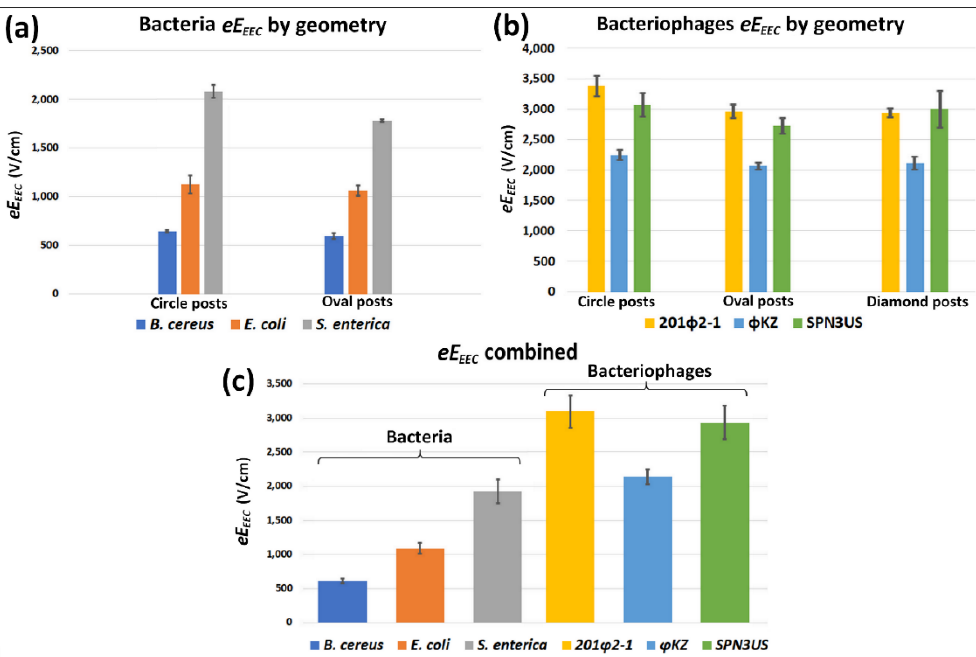
Figure 3. The 𝑒𝐸 𝐸𝐸𝐶 values are presented in each post shape per species for ( a ) the bacteria [13] and for ( b ) the bacteriophages [9]. ( c ) The 𝑒𝐸 𝐸𝐸𝐶 values obtained in each post shape were then averaged per species and are represented as a bar plot where the bacteria show lower overall values than the bacteriophages.